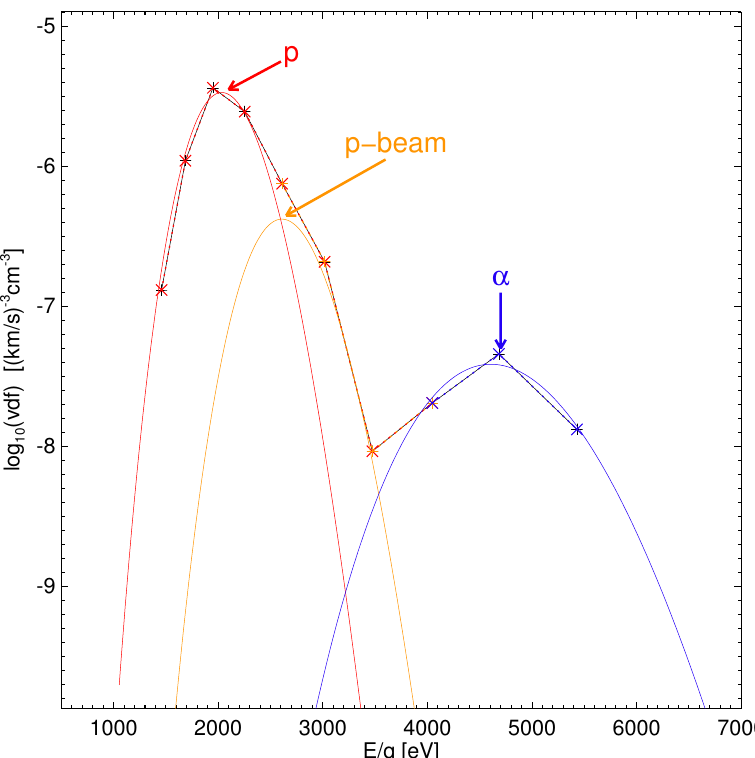
Figure 1. An example of the cut along the magnetic field direction through 3D Helios ion en- ergy distribution. Data measured on 11 March 1976 at 0302 UT are shown by crosses, the fit- ted distributions of different species (proton core—red, proton beam—orange and α particles— blue) by full lines. Note that the whole 3D distribution was fitted. The parameters of fits are: The proton core— N = 5 cm − 3 ; V = 614.7 km/s, V th (cid:107) = 30.0 km/s, V th ⊥ = 47.8 km/s; proton beam— N = 0.94 cm − 3 ; V = 665 km/s, V th (cid:107) = 25.6 km/s, V th ⊥ = 56.3 km/s; and α particles—